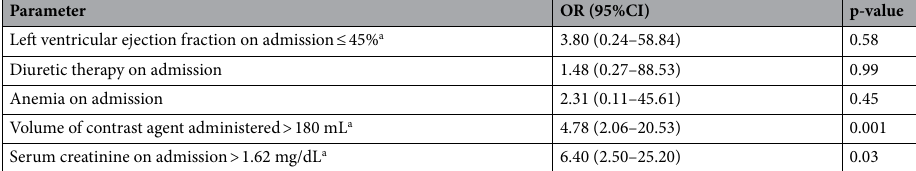
Table 3. Logistic regression analysis of predictors of contrast-induced nephropathy. Contrast-induced nephropathy was defined as an increase in serum creatinine by at least 25% 48 h following contrast administration vs . baseline. Anemia was considered present when hemoglobin was < 13 g/dL and/or the hematocrit was < 39% in males, and when hemoglobin was < 12 g/dL and/or the hematocrit was < 36% in females, respectively. a Cutoff values for left ventricular ejection fraction on admission, volume of contrast agent administered, and serum creatinine on admission were established using receiver operating characteristic